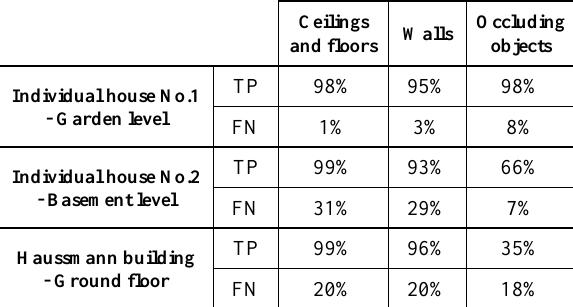
Table 9. Results of the classification of points into several classes